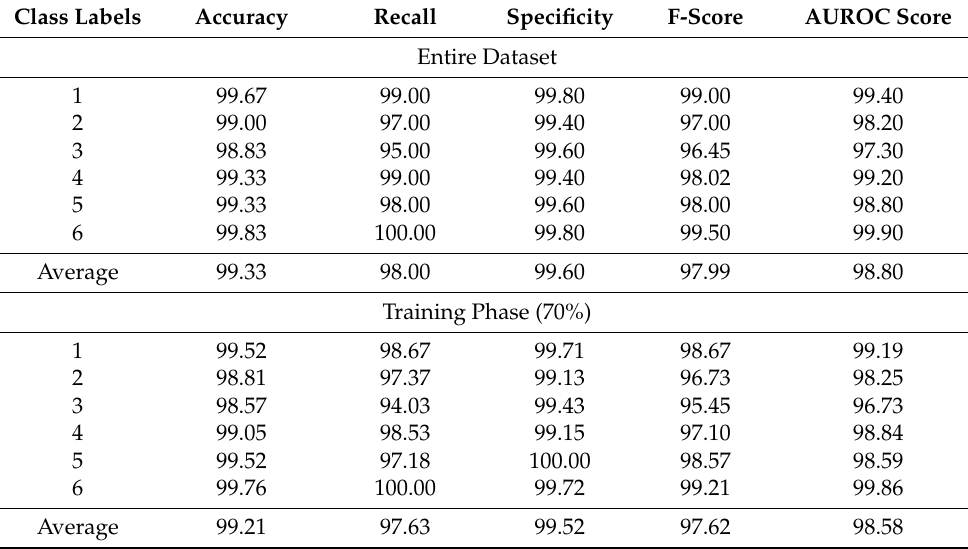
Table 3. HAR results of QWSA-HDLAR model on KTH